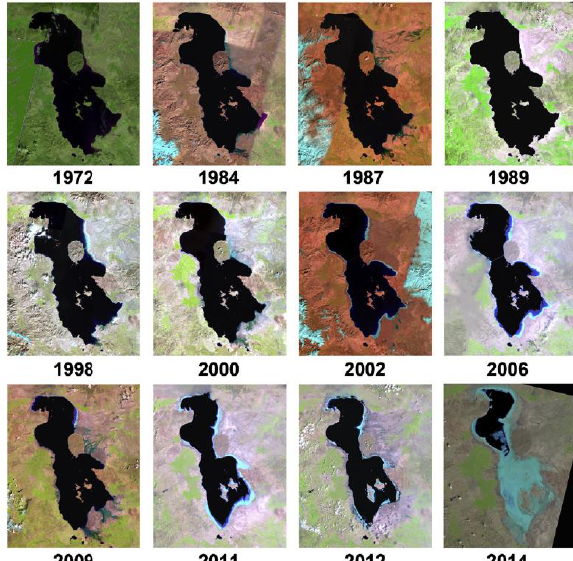
Figure 2. Changes in area of Lake Urmia from October 1972 to August 2014, derived from LandSat imagery (A. AghaKouchak , 2014).